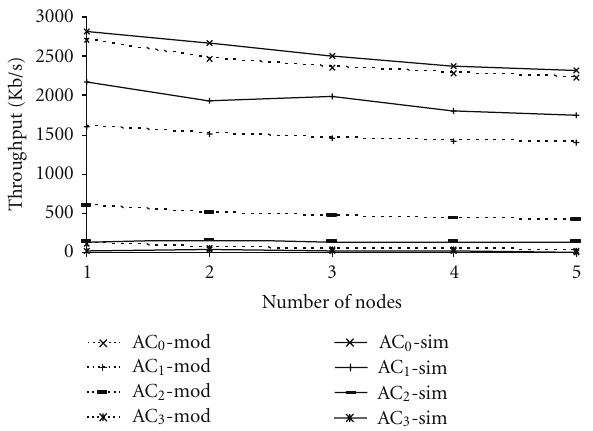
Figure 1: Saturated throughput, simulation versus a reference model.